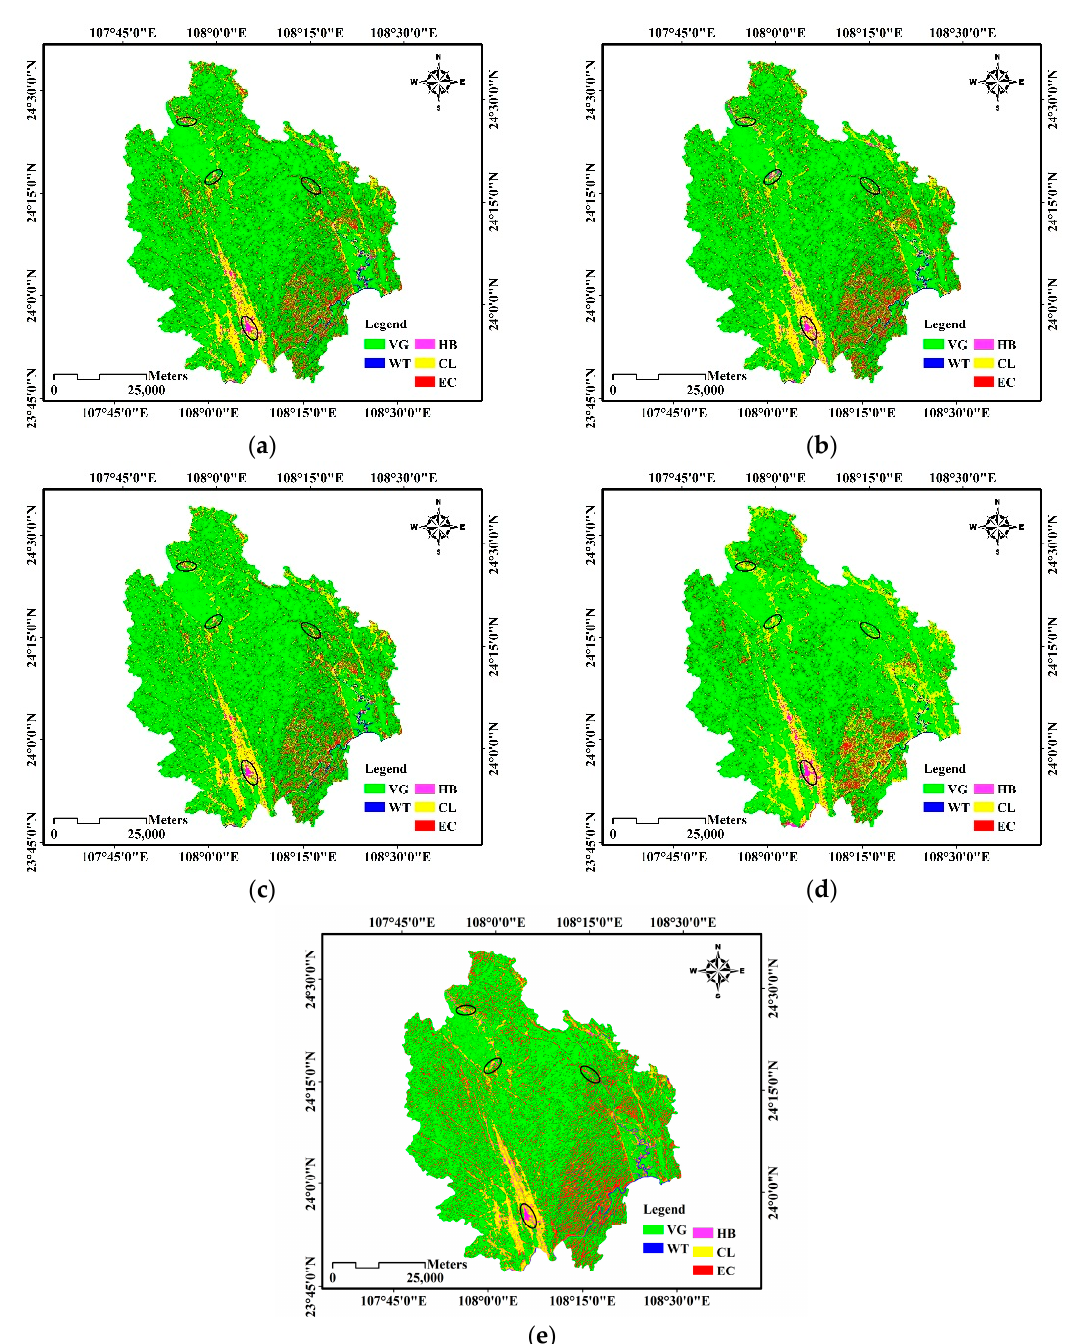
Figure 10. The results of classification in the second test area by: ( a ) the proposed method; ( b ) CL-DT; ( c ) SAE; ( d ) CART; and ( e ) RFs.